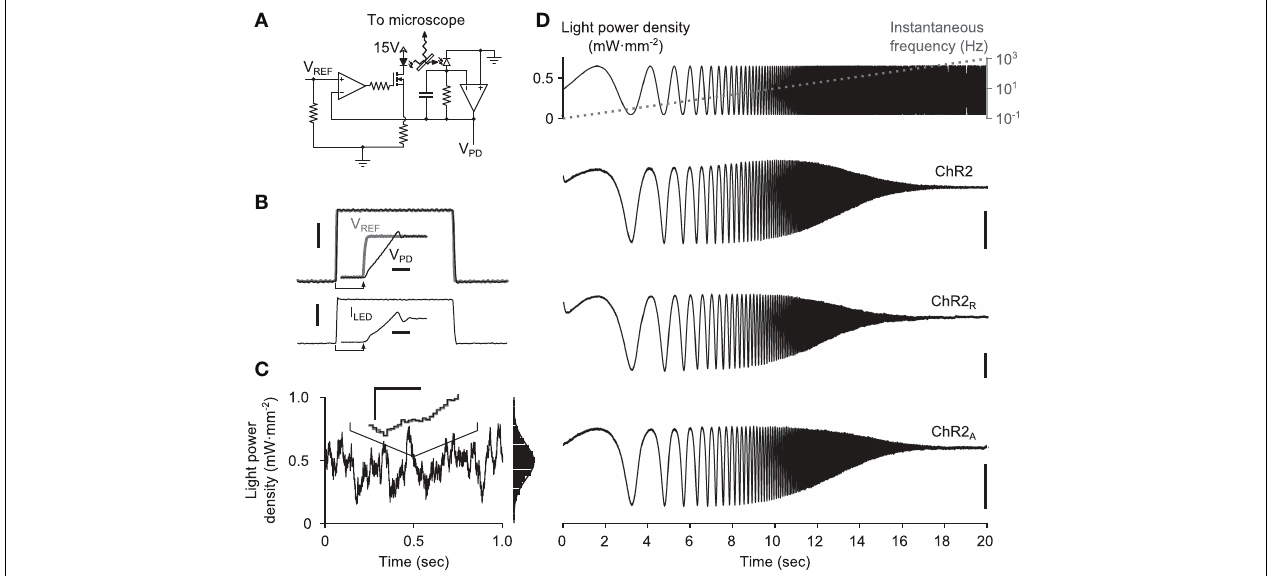
FIGURE 3 | Delivery of continuously-varying stimuli to neurons using ChR2. (A) Simplified schematic of the LED driver in optical feedback mode. The circuit uses an amplified photodiode to compensate for the non-linearities and temperature dependence of the LED, allowing arbitrary waveforms to be delivered to cells. (B) A 1-ms LED pulse, V PD (black), versus the reference voltage, V REF (gray). The current sourced to the LED is shown in the lower plot. Scale bars, 1mW · mm − 2 (top) and 250mA (bottom). Insets show the zoomed step onset with corresponding 5 μ s scale bars. (C) A computer generated